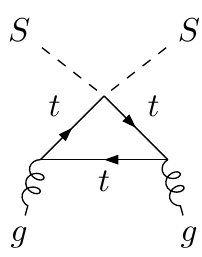
Figure 3 . Additional diagram to be considered in the evaluation of the S coupling to a nucleus via the constituting gluons of the latter, once the model Lagrangian includes an SStt dimension- five